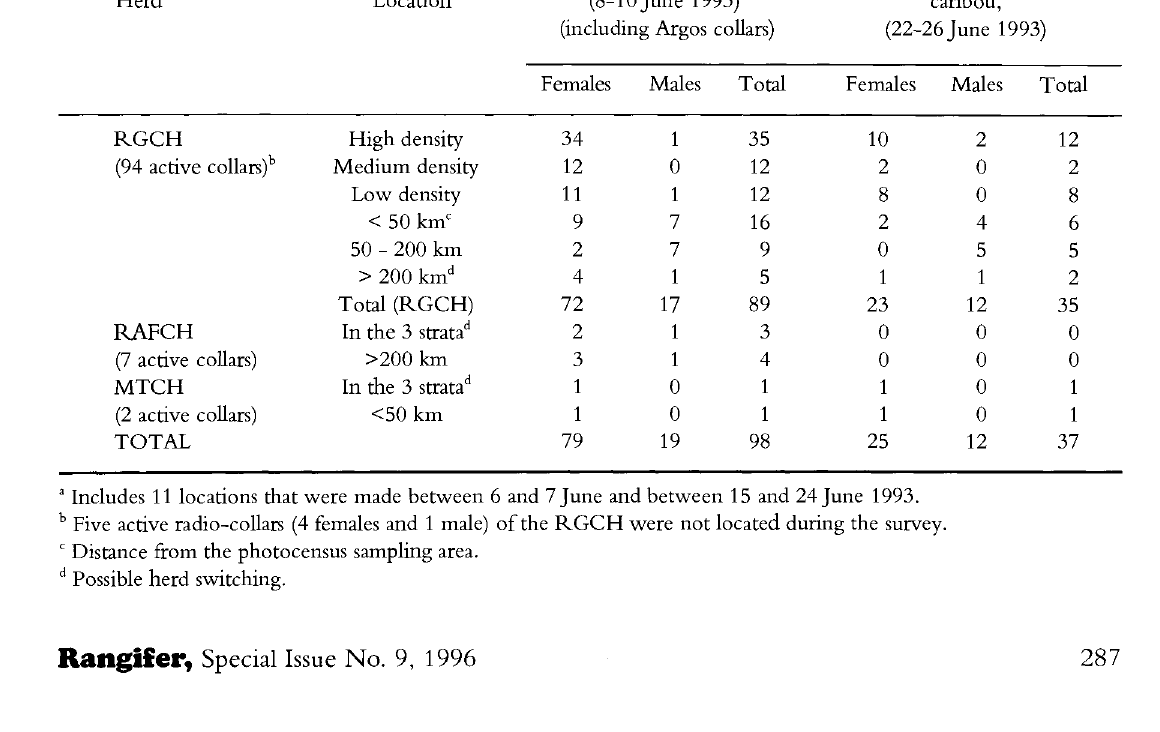
Table 1. Locations of radio-collared caribou during the telemetry survey (n = 103") and from Argos satellite data (n=37). Radio-collared